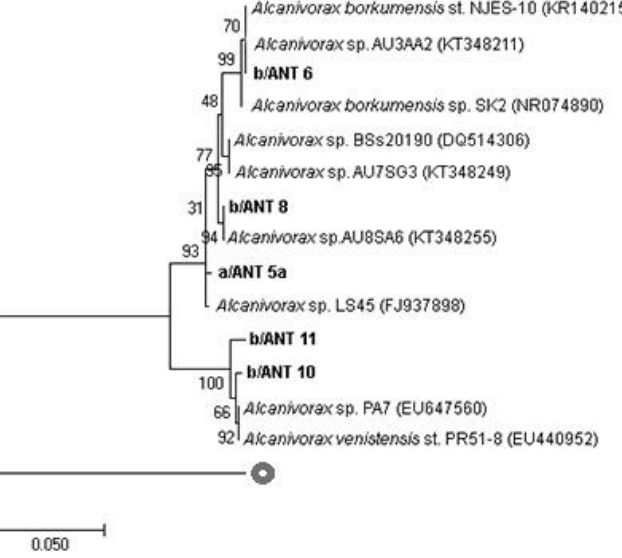
Figure 1. Rooted phylogenetic tree clustered by neighbour-joining of maximum likelihood values showing affiliation of complete bacterial 16S rRNA gene sequences to closest related sequences from Alcanivorax spp. Isolates are indicated in bold-type. Percentages of 1000-bootstrap resampling that supported the branching orders in each analysis are shown above or near the relevant nodes. All trees were rooted and outgrouped with 16S rRNA gene sequences of a Bacillus subtilis (AB192294). Vertical lines indicate evolutionary distance; each scale bar length corresponds to 0.05 fixed point mutations per sequence